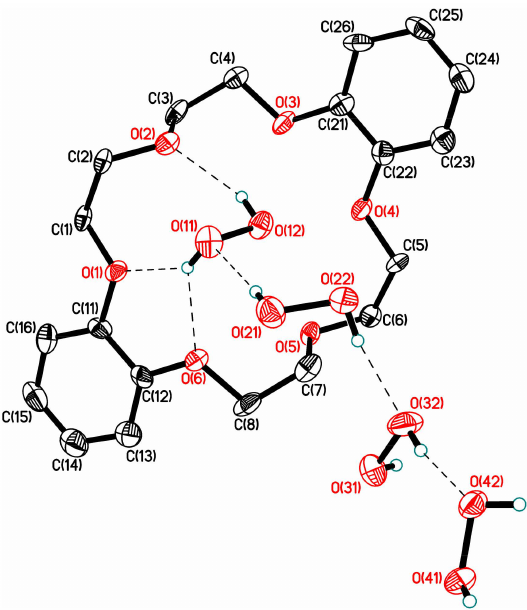
Figure 6. Asymmetric unit of III . Displacement ellipsoids are shown at the 50% probability level. The H-bonds are given by the dashed lines.